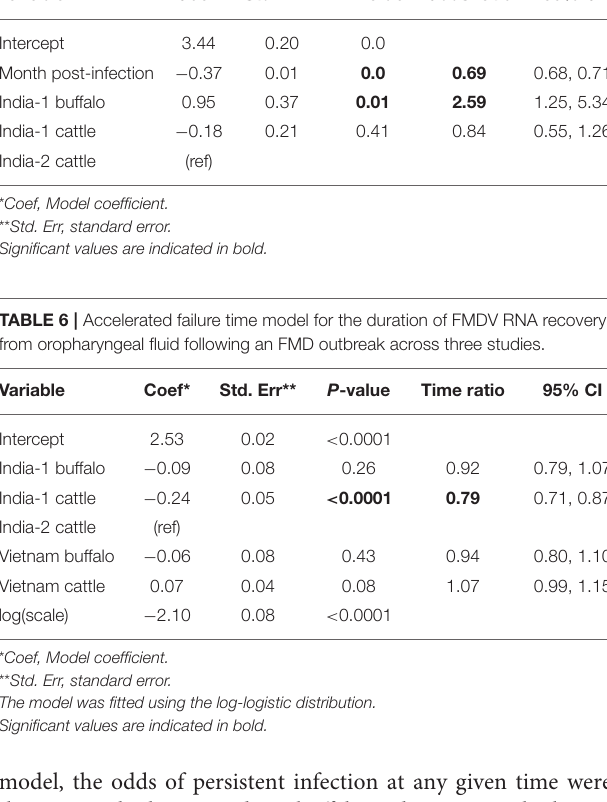
TABLE 4 | Accelerated failure time model for the duration of FMDV RNA recovery from oropharyngeal fluid following an FMD outbreak in India. Variable